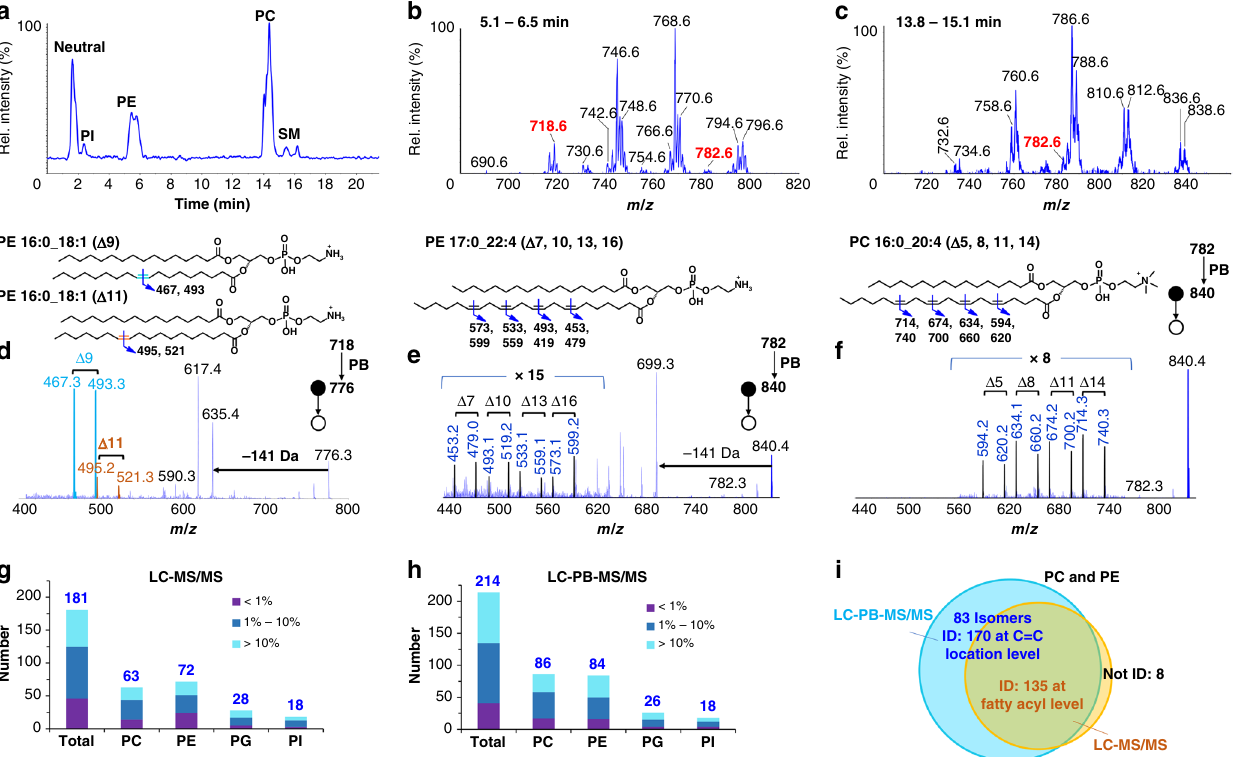
Fig. 2 Analysis of GPs in bovine liver polar extract. a Chromatogram of HILIC separation (0.1 µ g lipid per injection). b PE pro fi le resulting from 141 Da NLS (RT: 5.1 – 6.5 min); c PC pro fi le resulting from 184 m/z PIS (RT: 13.8 – 15.1 min). d LC – PB – MS/MS of PE 34:1 (RT: 5.7 min, m/z 776.3) reveals the presence of two C = C location isomers, PE 16:0_18:1( Δ 9) and PE 16:0_18:1( Δ 11). LC-PB – MS/MS of e PE 17:0_22:4 (RT: 5.2 min, m/z 840.4) and f PC 16:0_20:4 (RT: 14.3 min, m/z 840.4). The number of GP molecular species identi fi ed by g regular LC – MS/MS and h LC – PB – MS/MS. i Comparison of unsaturated PC